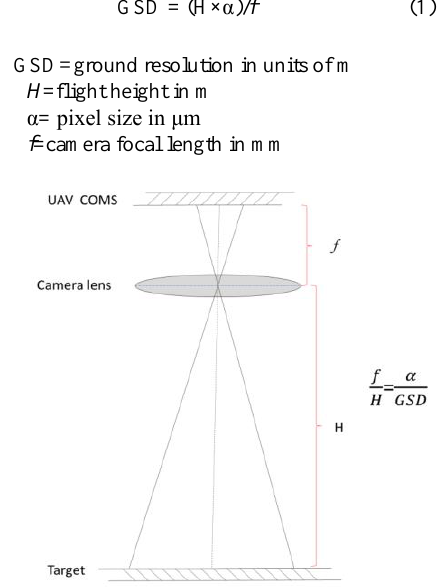
Figure 2.Image Spatial Resolution